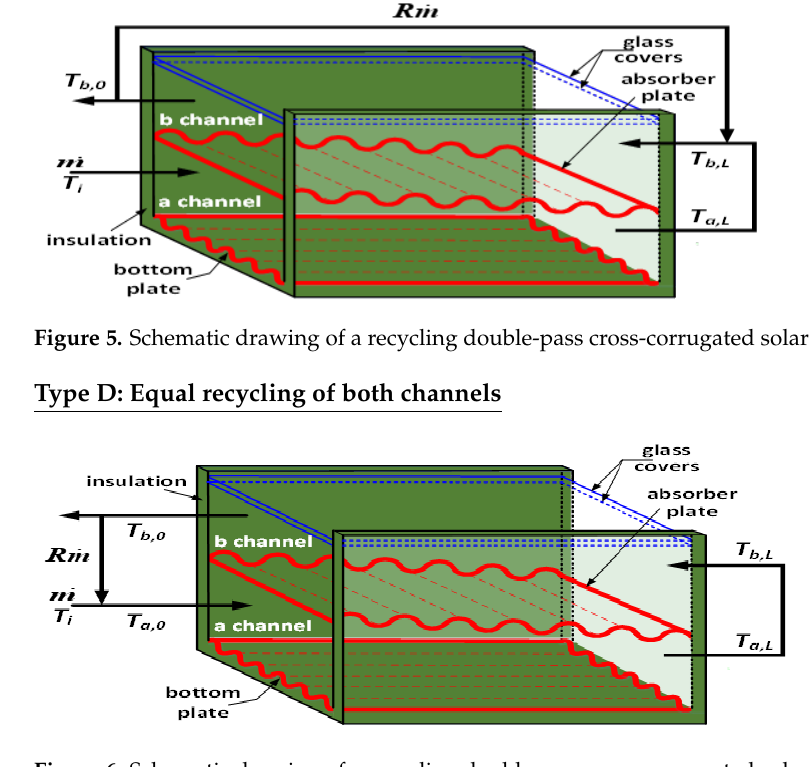
Figure 6. Schematic drawing of a recycling double-pass cross-corrugated solar air heater ( Type D ). Table 2. Theoretical predictions of the collector thermal efficiency and outlet temperature for all flow types.